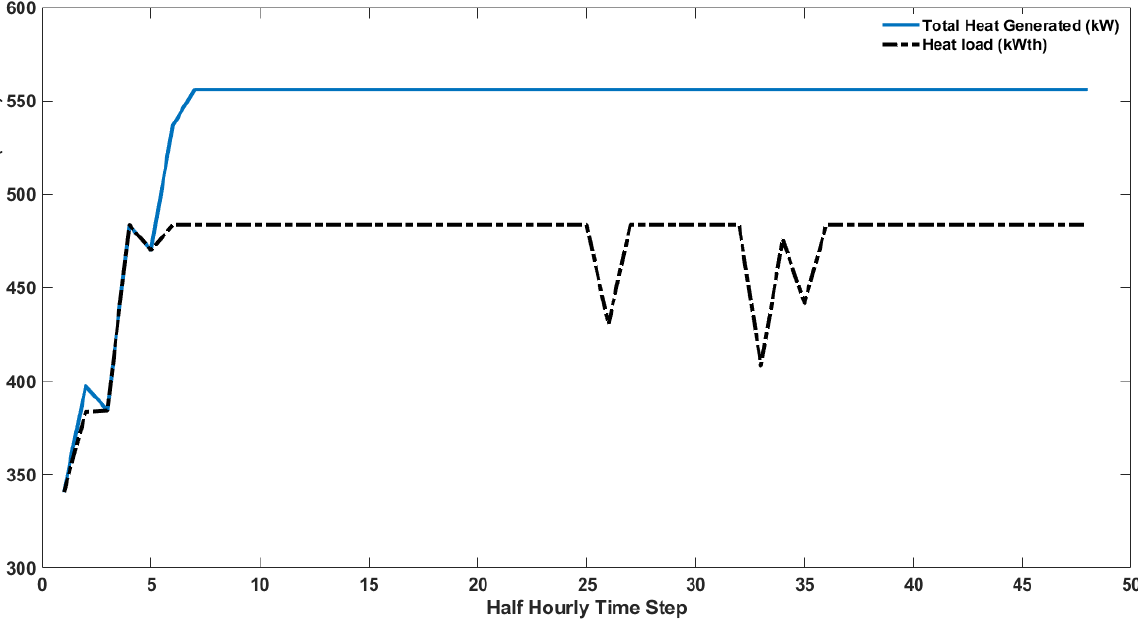
Figure 18. Total heat generated by the CHP units and heat demand (online optimisation).